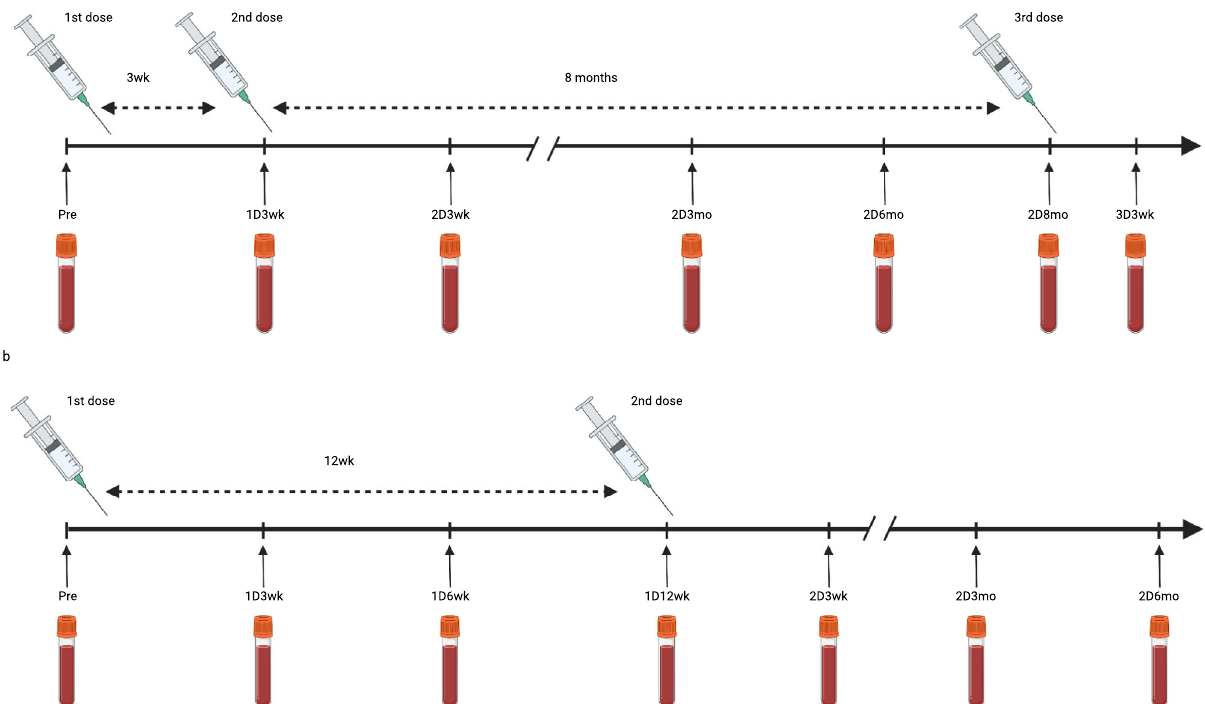
Fig. 1 Timeline of vaccinations and samplings with 3-week and 12-week dosing intervals. a In the short 3-week dose interval group sera were collected before vaccination (Pre), three weeks (1D3wk) after the fi rst vaccine dose (1D), and three weeks (2D3wk), three months (2D3mo), six months (2D6mo), and eight months (2D8mo) after the second vaccine dose (2D), as well as 3 weeks (3D3wk) after the third vaccine dose (3D). b In the long 12-week interval dose group sera were collected before vaccination (Pre), three weeks (1D3wk), six weeks (1D6wk) and twelve weeks (1D12wk) after the fi rst vaccine dose, and three weeks (2D3wk), three months (2D3mo) and six months (2D6mo) after the second vaccine dose. Created with